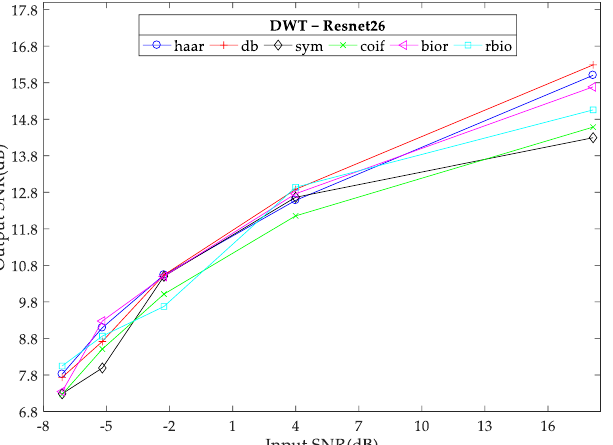
Figure 9. Trends of the best denoi sing results of DWT−Resnet26 with different SNR real seismic data under different wavelet bases.